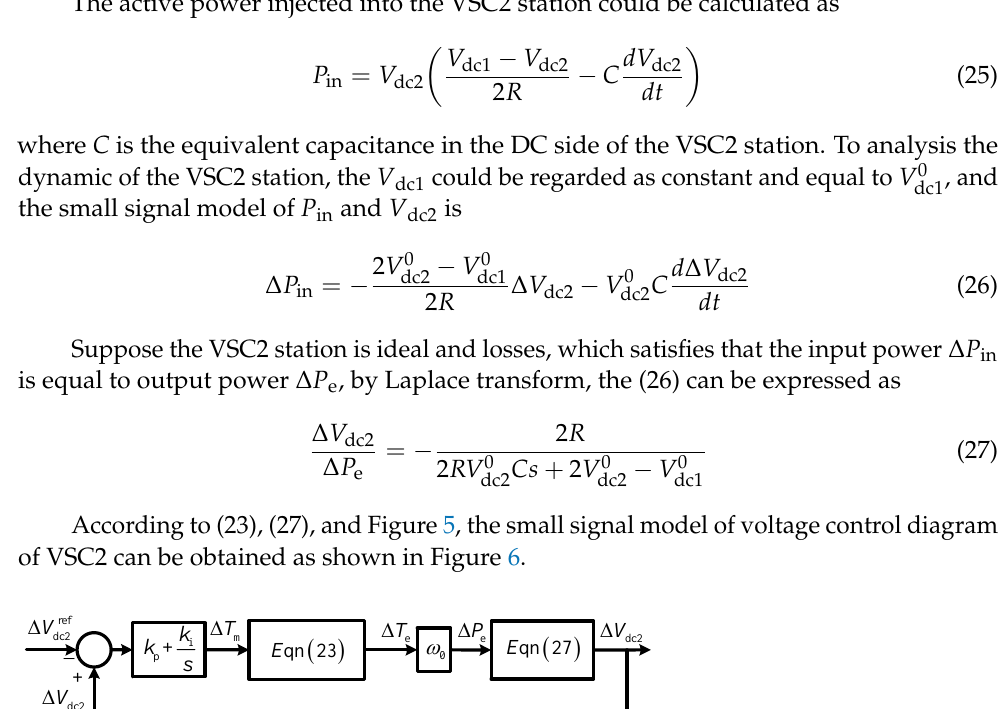
Figure 5. Small signal model of P-f control diagram of VSG.